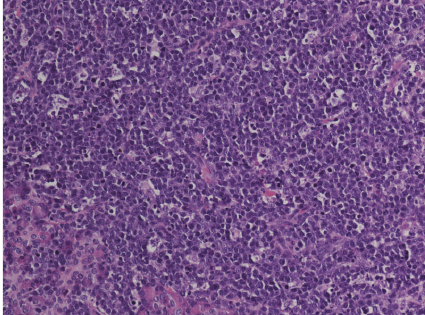
Figure 3: H&E stain of a biopsy specimen from the pancreas showing the characteristic “starry sky appearance” seen in Burkitt